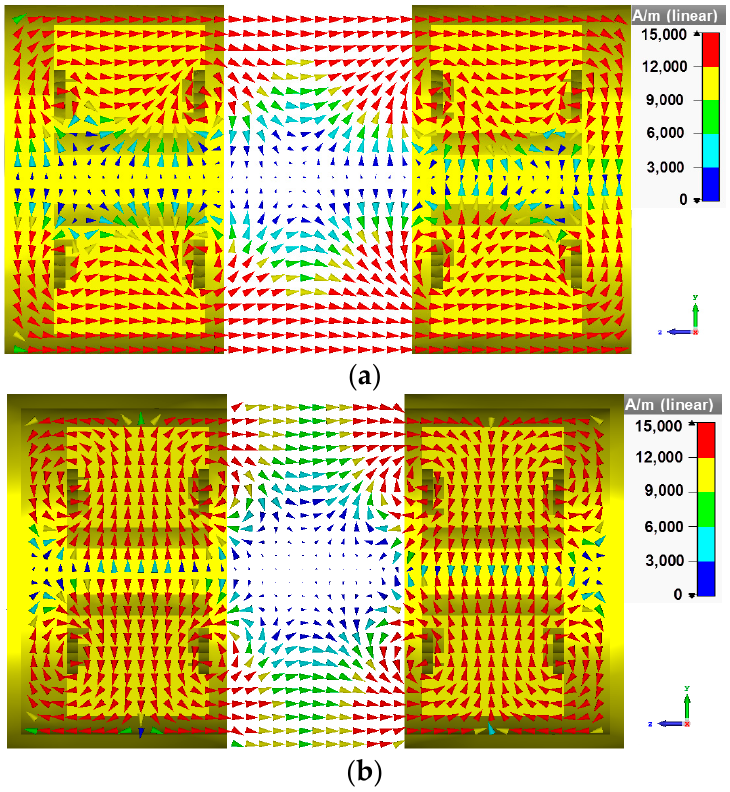
Figure 6. Coupling between two resonators: ( a ) Magnetic coupling for the π mode, ( b ) magnetic coupling for the π + 1 mode.